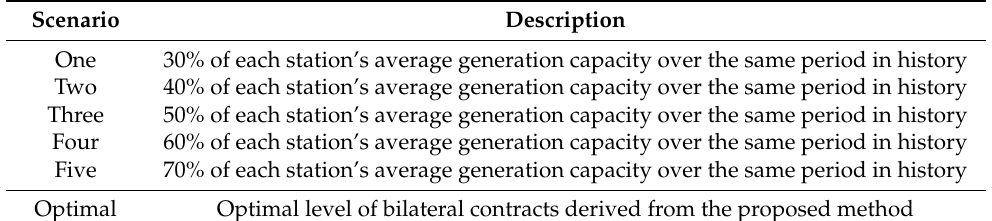
Table 2. Different regulation scenarios for comparison.